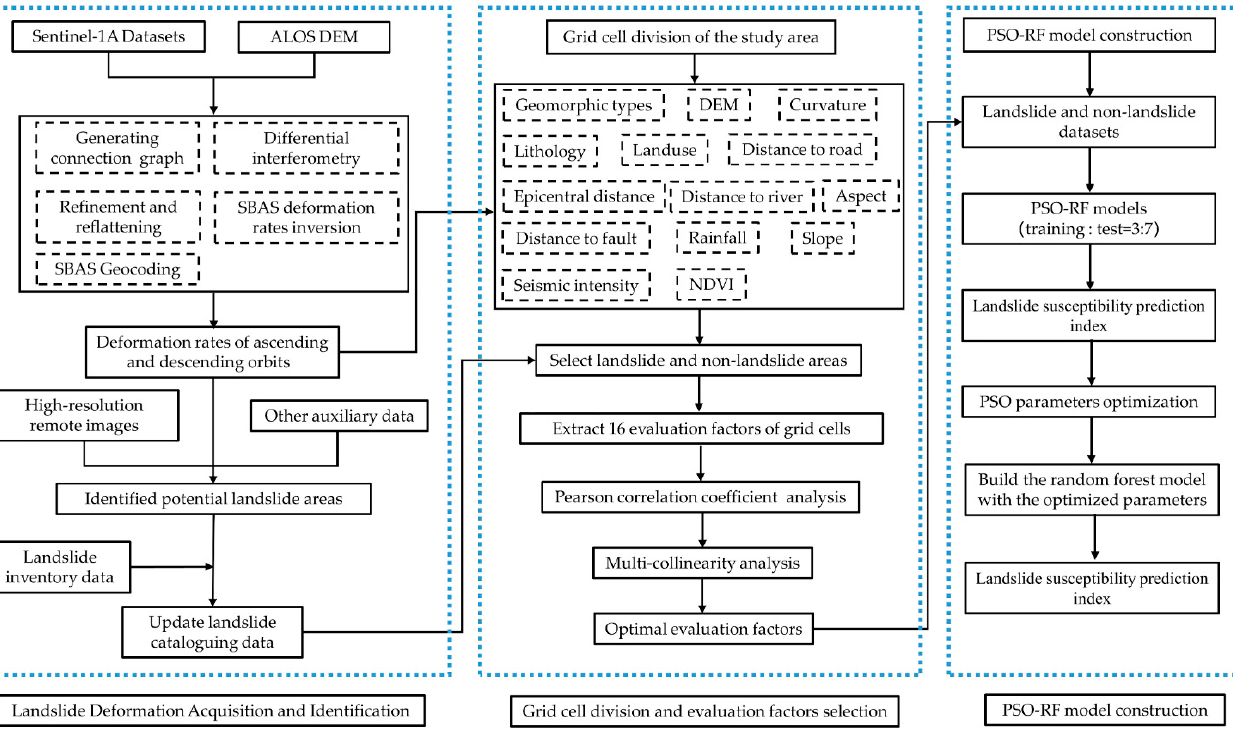
Figure 3. Technical